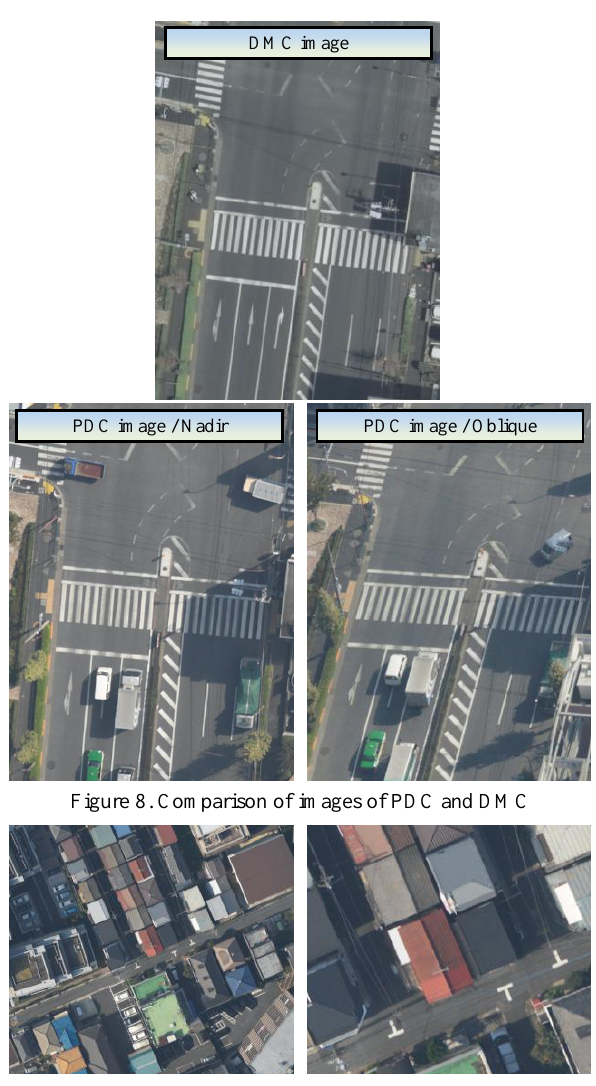
Figure 9. Enlarged PDC